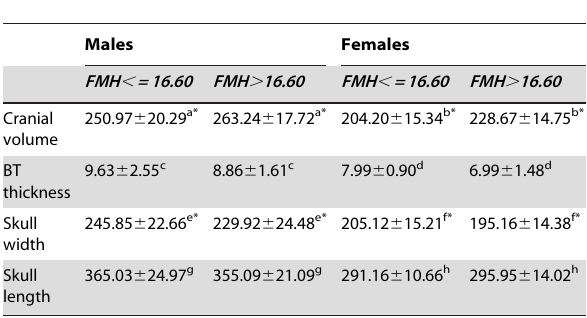
Table 3. Measurements of lion skulls with FM stenosis (FMH , = 16.60 mm) and those with larger FM opening, comparing males and females